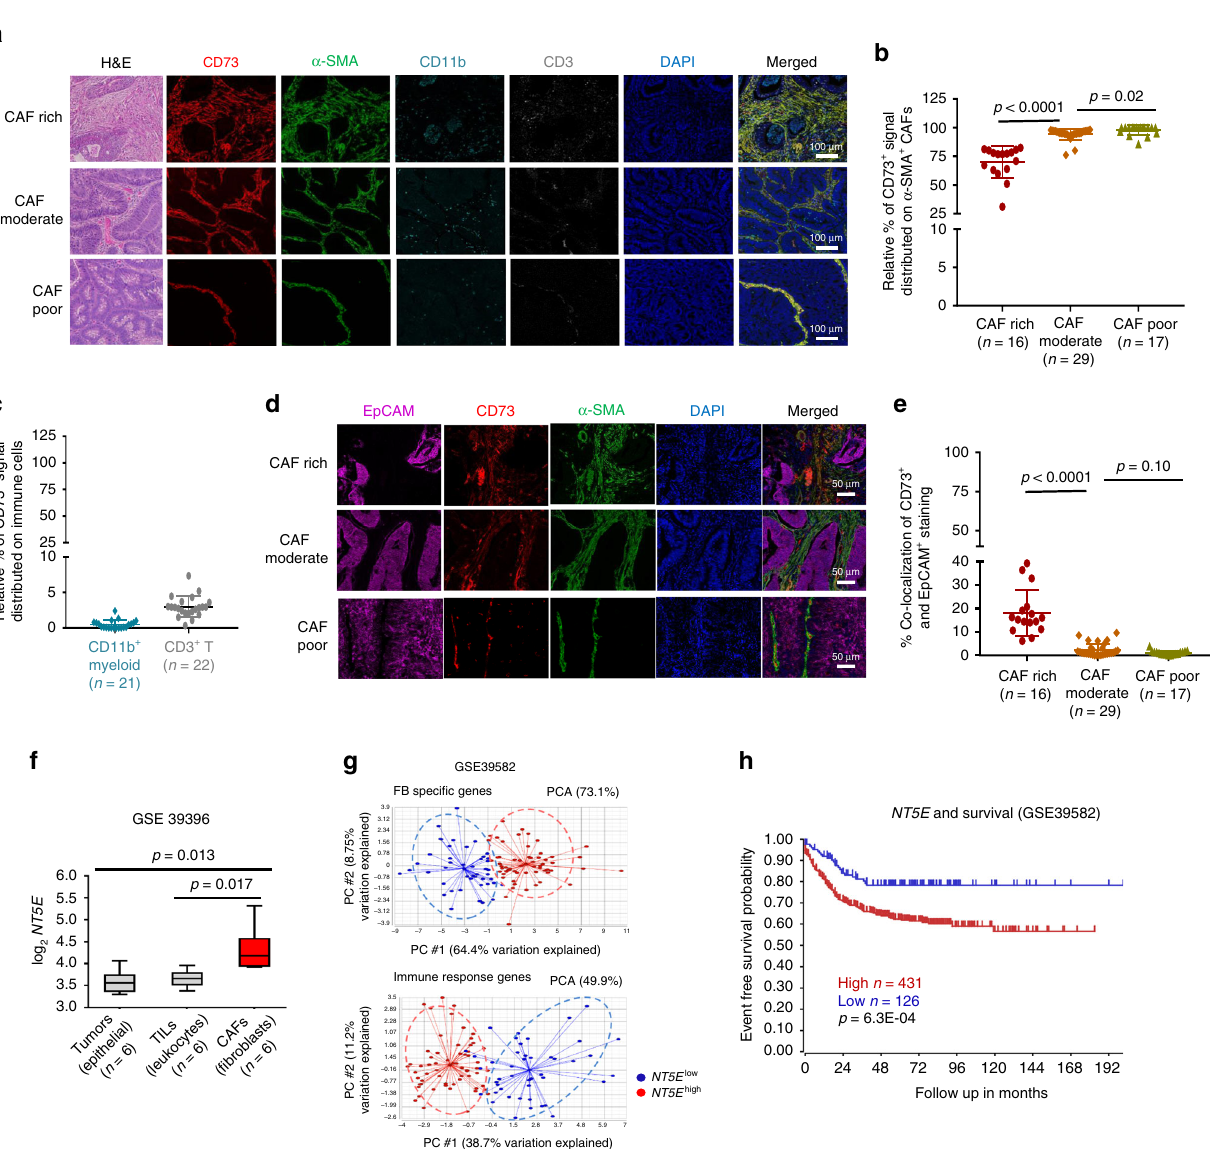
Fig. 1 Elevated CD73 levels in human CRCs are associated with CD73 hi -CAF abundancy and poor clinical outcomes. a Histological H&E examination (left) and multiplex immunohistochemistry (IHC) staining of CD73 (red), a-smooth muscle actin (a-SMA, green), CD11b (cyan), and CD3 (gray) were performed with de-identi fi ed FFPE CRC-specimen. Nuclei were counterstained with DAPI (blue). Representative images illustrate the level of CD73 expression and its bio-distribution on CAFs ( α -SMA + ), CD11b + myeloid, and CD3 + T cells in CAF-rich, moderate, and poor specimens. Scale bars, 100 μ m. b , c Randomly selected and evenly distributed areas (~5 × 10 5 mm 2 ) from each multiplex IHC-stained CRC specimen were analyzed for the percentage of CD73 + signal that distributed on α -SMA + b , CD11b + , and CD3 + cells c among the total CD73 + region in each area, which was set as 100%, was calculated and plotted. d Multiplex IHC staining was performed to determine tumor (EpCAM, magenta), CD73 + (red) cells, and CAFs ( α -SMA, green) distribution and their potential co-localization. Scale bars, 50 μ m. e The percentage of CD73 + signal on EpCAM + tumors against total CD73 + region was presented. f CD73 (NT5E) gene expression in paired puri fi ed CRC-CAFs (red box), TILs, and tumors from published dataset (GSE39396) was compared. g Principle component analysis was performed with a published CRC cohort dataset (GSE39582) of 557 CRC specimens. The NT5E high (red) and NT5E low (blue) specimens were fi rst de fi ned by their CD73 expression in the top 20% and bottom 20% level, respectively, and clustered against a group of 18 fi broblast- speci fi c (FB) genes that shows a positive correlation and against a group of 15 pre-de fi ned group immune effector function associated genes as Immune response genes that reveals negative association. h The Kaplan – Meier survival curve demonstrates clinical correlation of NT5E high (red) and NT5E low (blue) expression in CRC patients (GSE 39582) with event-free survival. Data depict mean ± SEM. Unpaired Student ’ s t -test for b , c , e and paired Student ’ s t -test for f . Source data are provided in the Source Data fi among all cellular subsets of the TME, we employed ectopic TME correlate positively with CAF abundancy, augmented murine tumor models. Among the MC38-CRC, EG7 T-lym- immunosuppression, and poor prognosis. phoma, and B16 melanoma models, CAFs were mostly CD73 hi cells compared with TILs and tumors (Fig. 2a, Supplementary Fig. 2a, b). Unlike CD73 − /lo human CRC-adenocarcinomas CAFs are the major source of CD73 activity in the EG7 TME . (Fig. 1), MC38 tumors were CD73 + with a comparable level of For comparative analysis of the CD73 expression and function